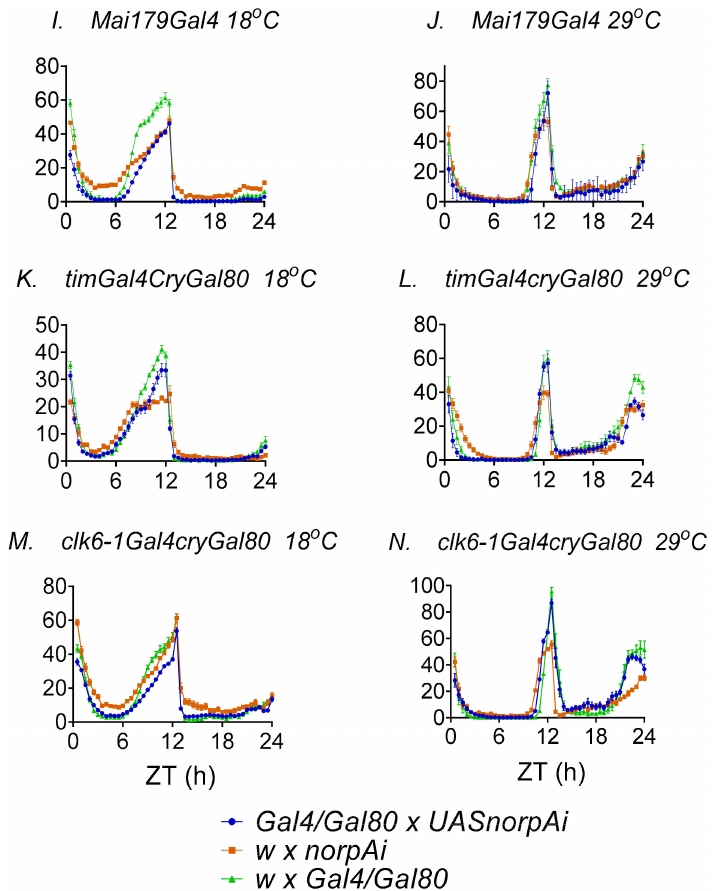
Figure 4. Locomotor activity: norpA RNAi in clock cells under di ff erent temperatures. norpA RNAi and locomotor behaviour. ( A – N ) Gal4 / Gal80 Genotypes and temperature given above each panel. Y axis, mean locomotor event / 30 min time bin. X axis, ZT, ZT 0–12 light, ZT 12–24 dark. Blue trace is experimental Gal4 / Gal80 x UASnorpAi ; brown is w x UASnorpAi ; green is w x Gal4 / Gal80 . Mean +/ - sem. Blue arrows show significant e ff ects via Kruskal–Wallis ANOVA and Dunn post-hoc test of EZt50 and MZt50, where the experimental (blue) genotype was significantly di ff erent from both control (brown, green) genotypes. EZt50 and MZt50 allow normalisation of the total levels of activity among